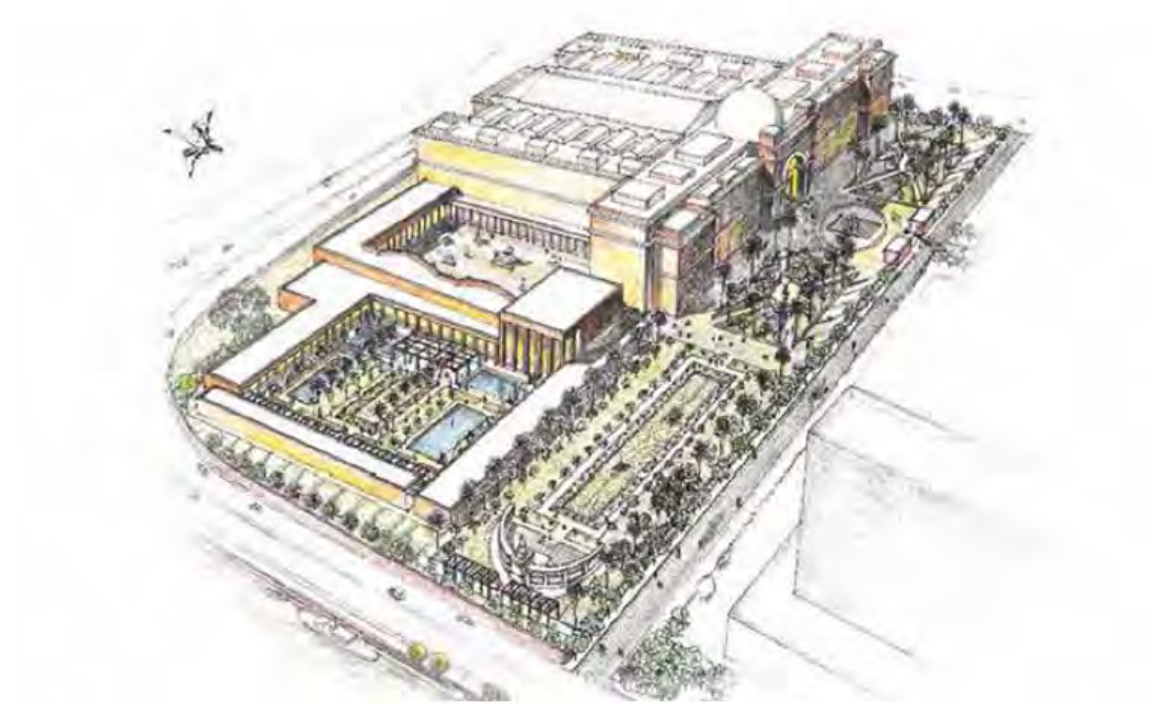
Figure 7. The conceptual design for the extension of the Egyptian museum by